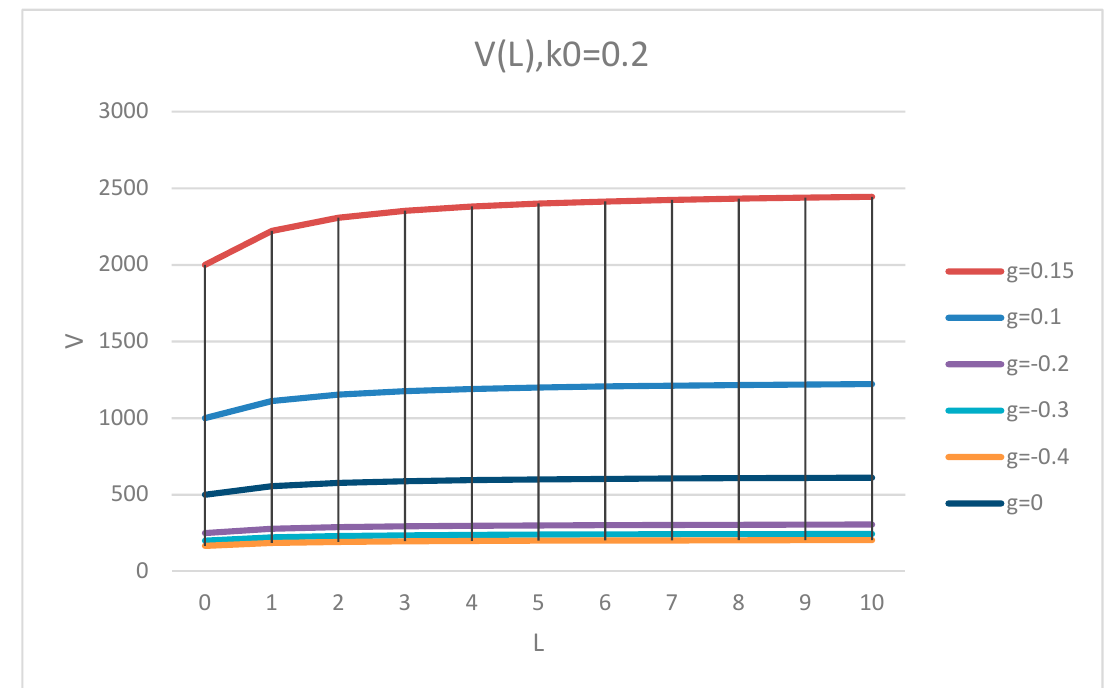
Figure 6. Dependence of company value V on leverage level L in Generalized Modigliani–Miller theory (GMM theory) at k 0 = 0.2 and g = 0; 0.1; 0.15; − 0.2; − 0.3; − 0.4. Table 6. Dependence of company value V on leverage level L in Generalized Modigliani–Miller theory (GMM theory) at k 0 = 0.3 and g =